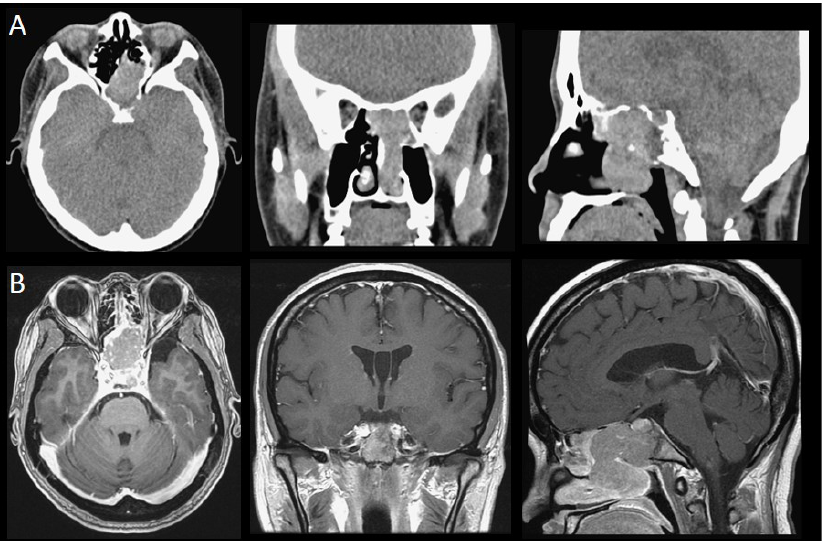
Figure 2. CT and MRI images of sinonasal metastatic cancers: ( A ) A 37-year-old female